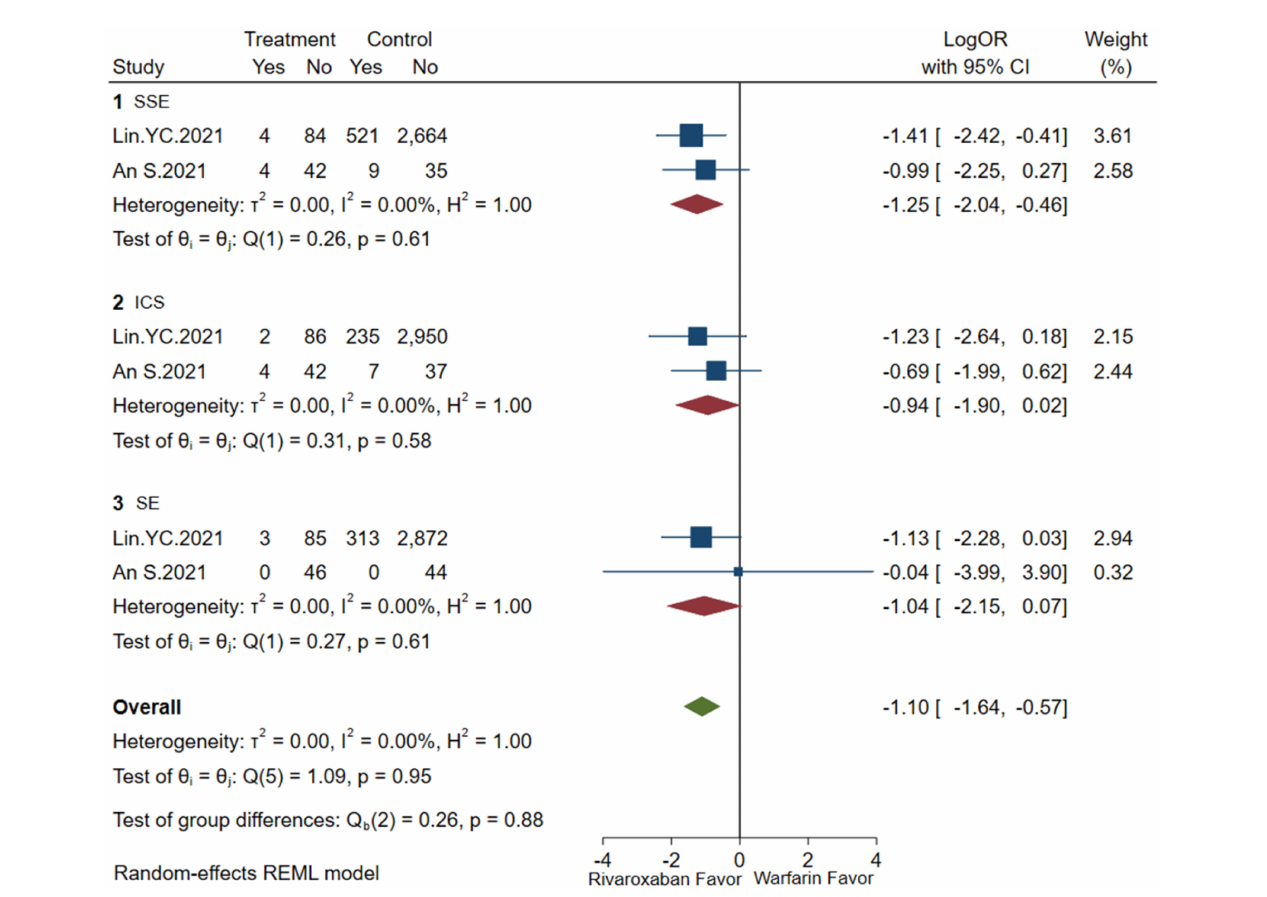
FIGURE4 Embolism of low-dose rivaroxaban (SSE, composite of stroke and systemic embolism; ICS, ischemic stroke; SE, systemic embolism).